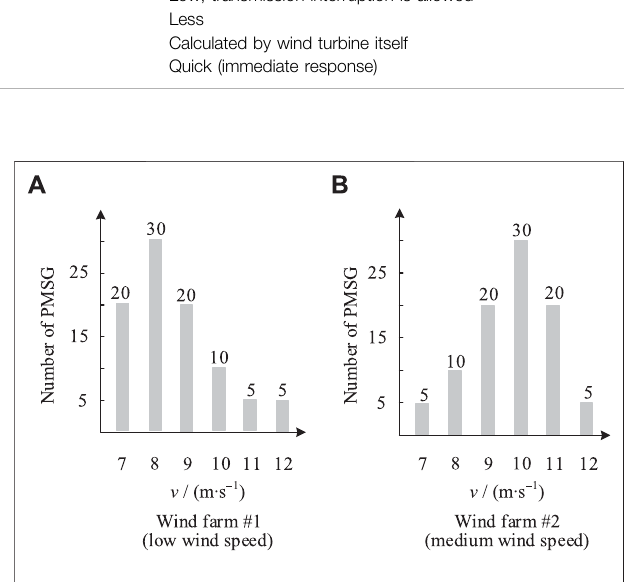
FIGURE8| Distribution ofD-PMSGs operating indifferent wind speeds.